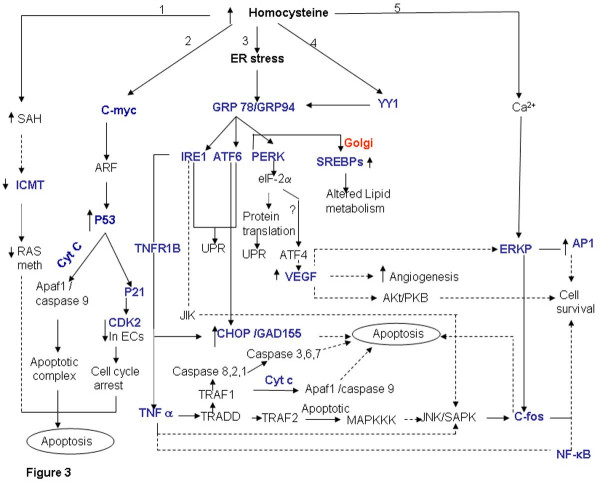
Elevated homocysteine levels and apoptosis. Elevated levels of homocysteine directly (branch 1 and 2) or via ER stress (branch 3 and 4) lead to apoptosis. Homocysteine also might lead to cell survival via calcium dependent ERK phosphorylation (branch 5). The genes marked in blue have been identified by literature based searches as mentioned in the methods section. The solid and dotted lines indicate direct and indirect (multi step) interaction/ conversion respectively.